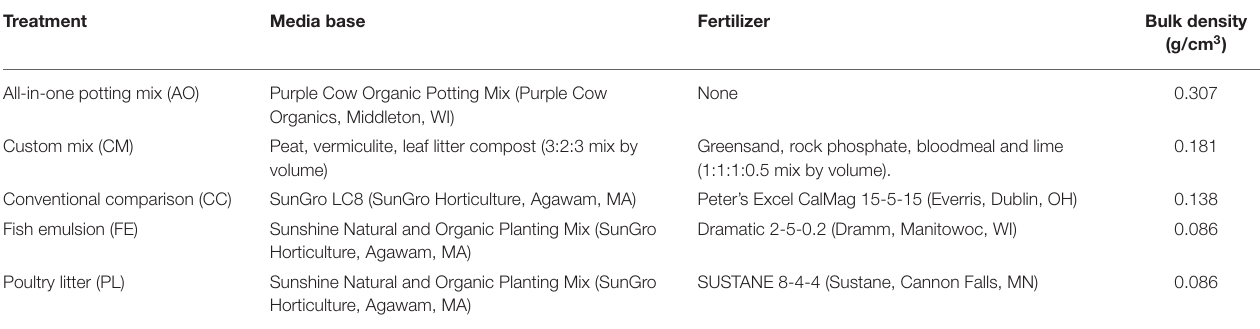
TABLE 1 | Fertility treatment combinations of media, fertility sources, and bulk densities of compared media.